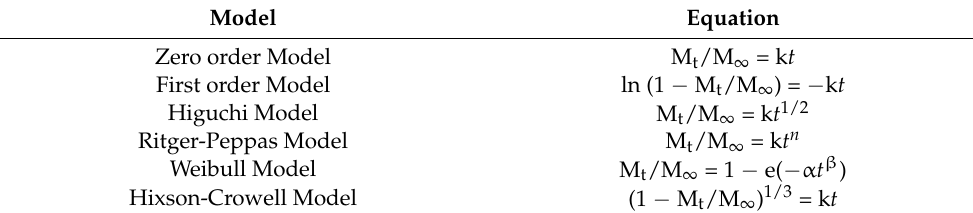
Table 1. Release model